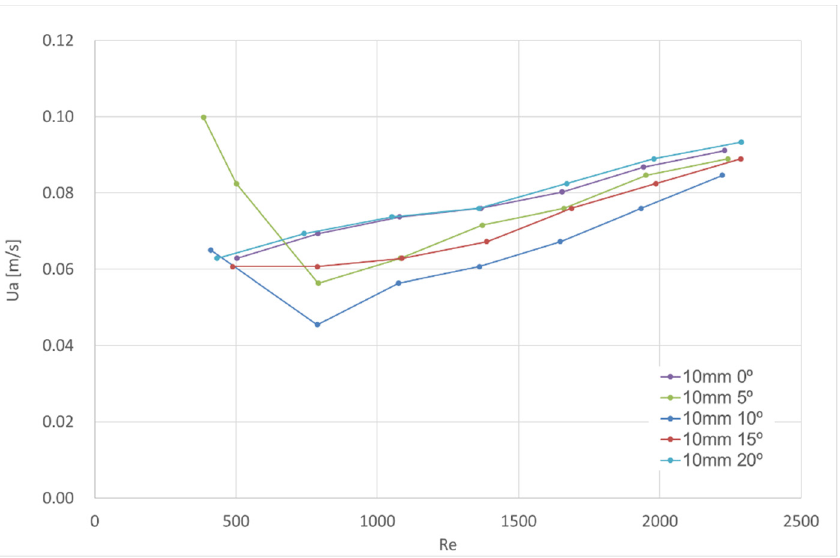
Figure 7. Test results for visual aerodynamic sealing of the air curtain for the nominal nozzle thickness of 10 mm.